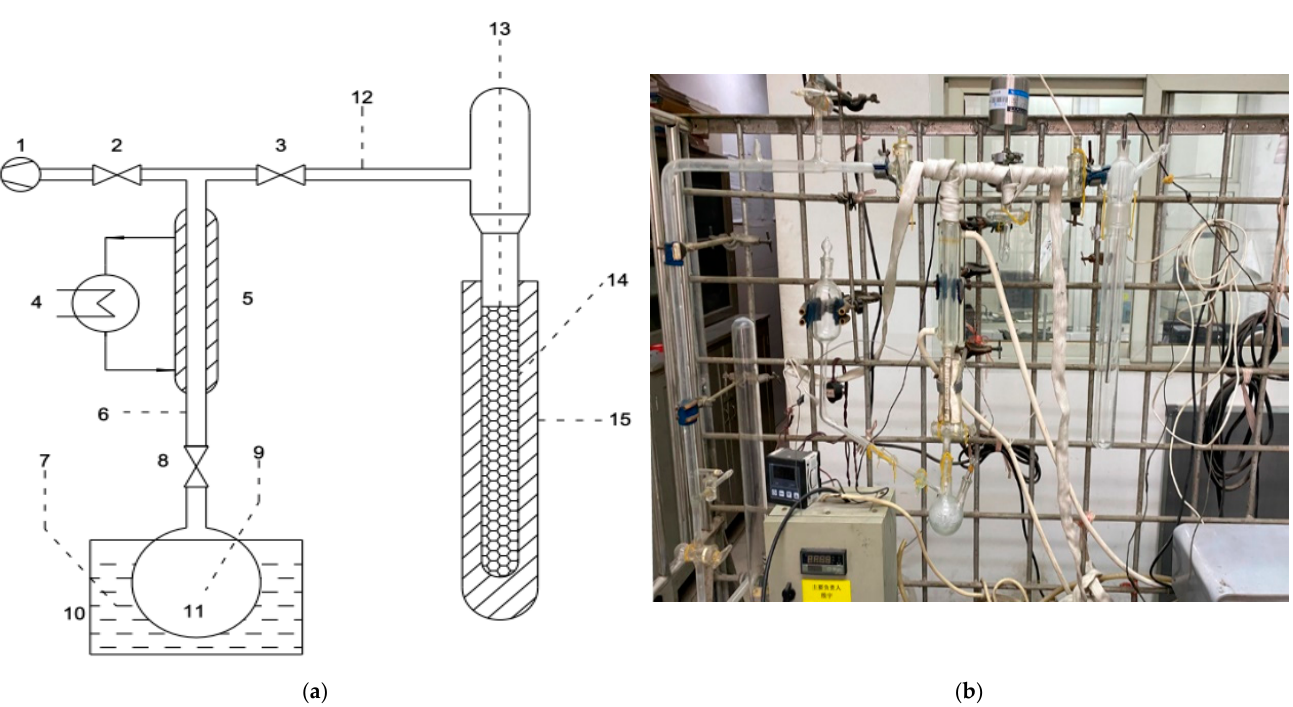
Figure 2. Schematic diagram ( a ) and overall view ( b ) of adsorption cooling device system for an MIL-101/20%FLG-water working pair. 1-vacuum pump, 2,3,8-valve, 4-thermostat, 5-condenser, 6-level gauge, 7,9,13-thermocouple, 10-refrigerator, 11-evaporator, 12-vacuum gauge, 14-adsorber, 15-heat exchanger.